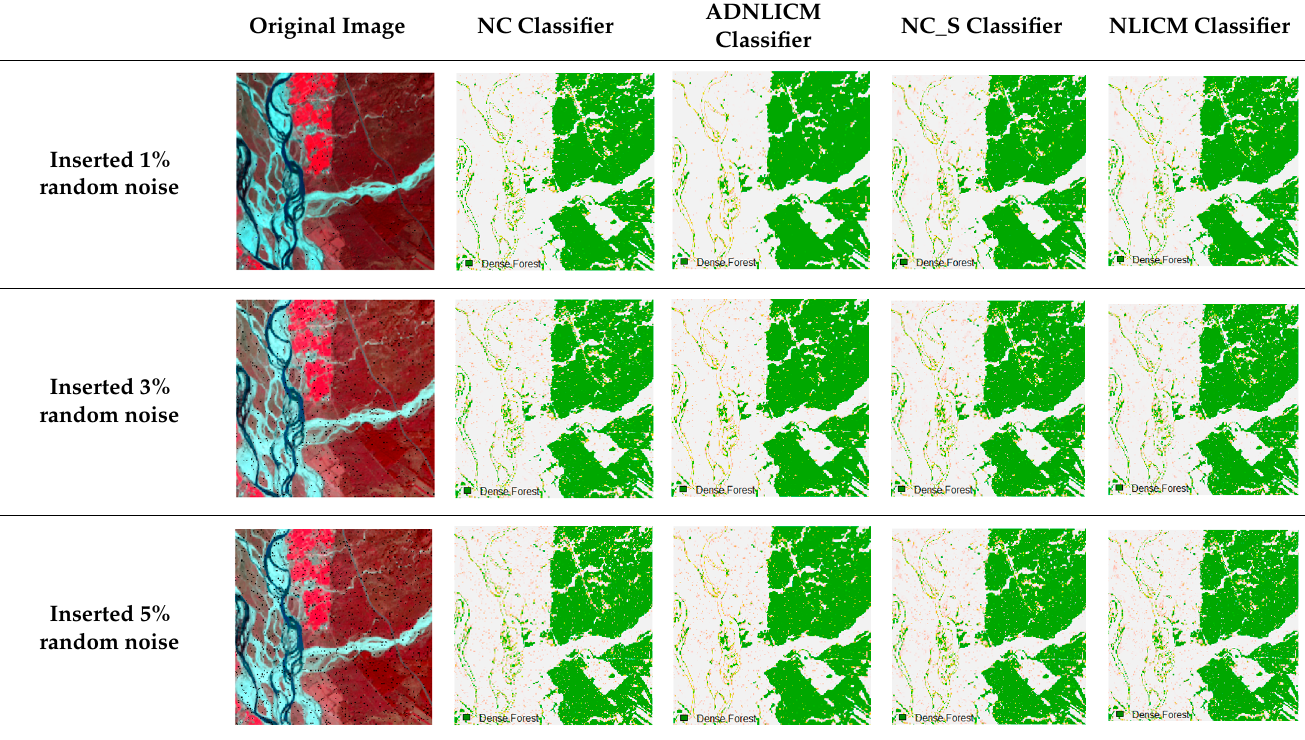
Table 7. Landsat-8 original and dense forest classified class image with respect to different random salt-and-pepper noise (for site 1 (Haridwar)). Original Image